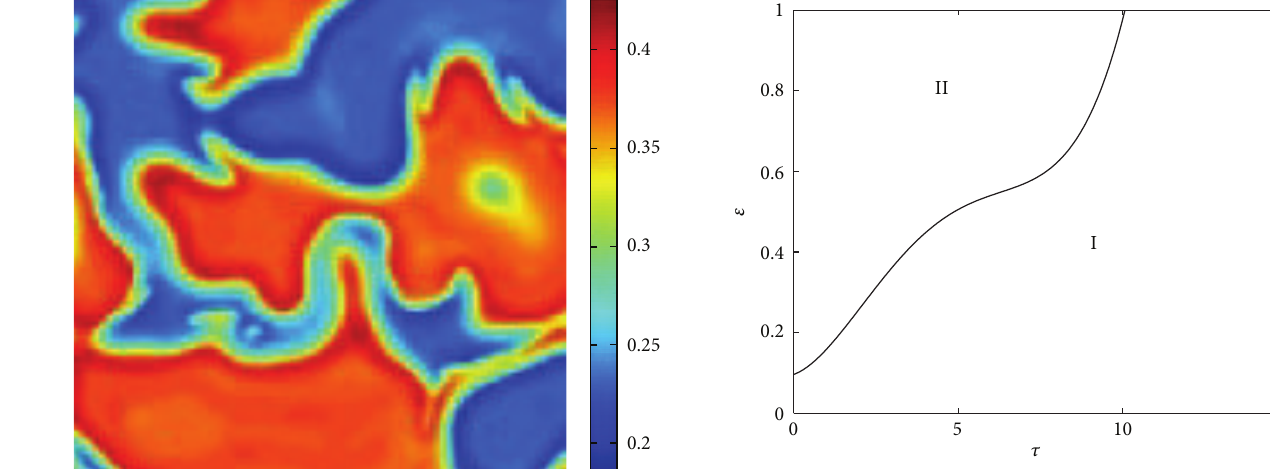
Figure 5: Regions of pattern structures of systems (1a) and (1b) with respect to noise intensity and temporal correlation for ] ̸=0 . I: chaotic pattern; II: no chaotic